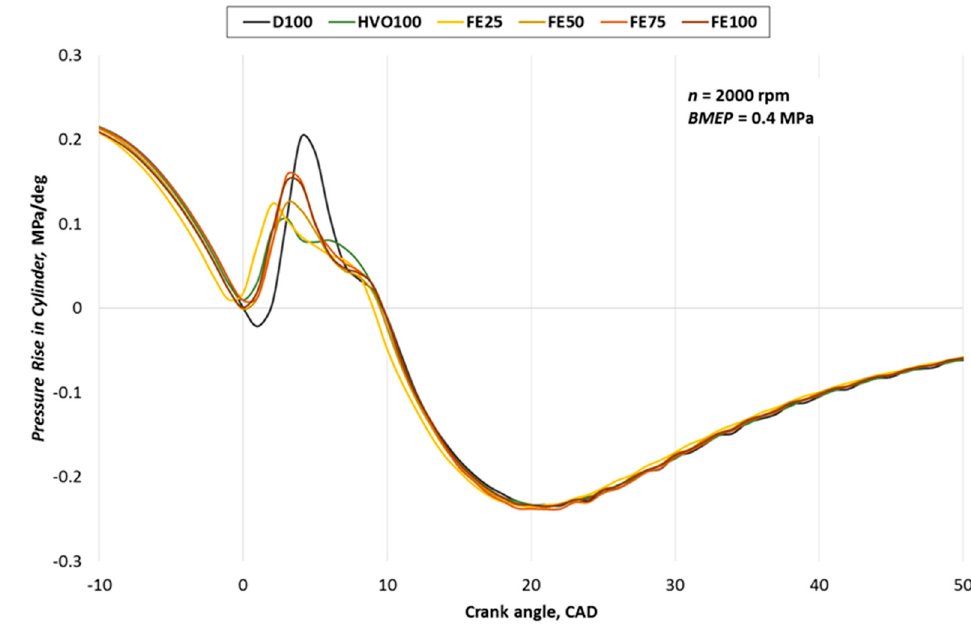
Figure 4. Pressure rise in the cylinder depending on the CAD.